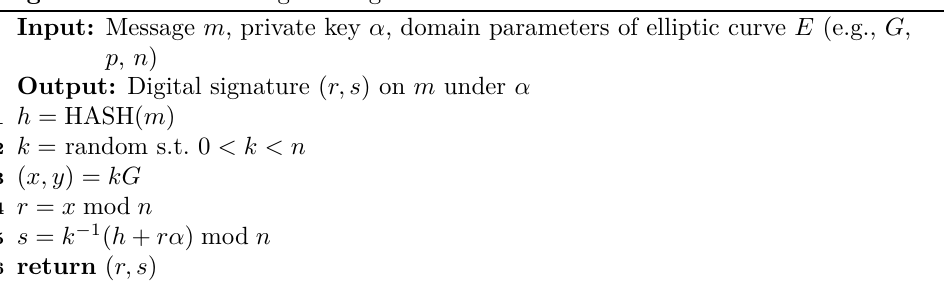
Algorithm 2: ECDSA signature